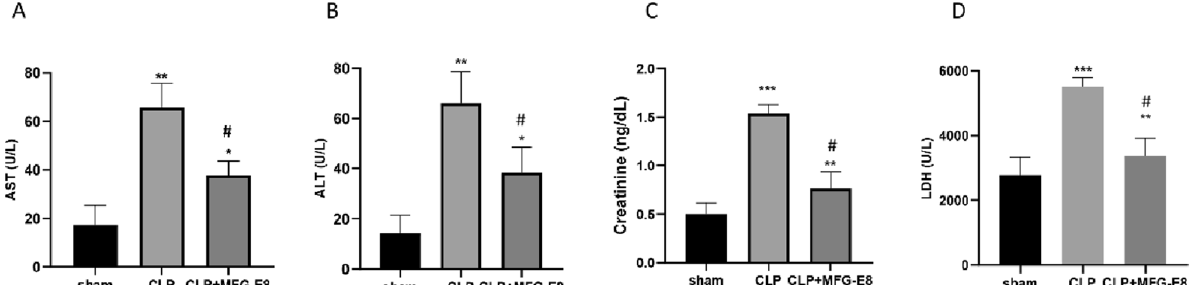
Figure 3. Treatment with recombinant MFG-E8 attenuates organ injury. Levels of AST ( A ), ALT ( B ), Creatinine ( C ), and LDH ( D ) were measured 24 h after CLP and found to be reduced in the rmMFG-E8 treatment group. Data are expressed as means ± SEM and compared by one-way ANOVA by Dunn’s and SNK method, and Mann Whitney Rank Sum test (*p < 0.05 versus sham group; #, *p < 0.05 versus CLP group; *p < 0.05, **p < 0.01, ***p <